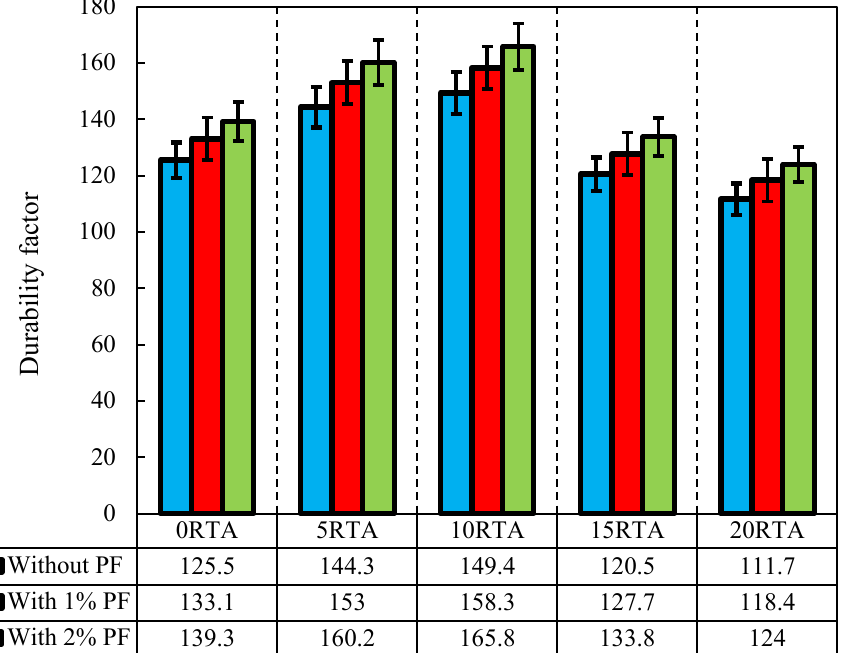
Figure 22. Durability factor of the concrete having different PF and RTA fractions.